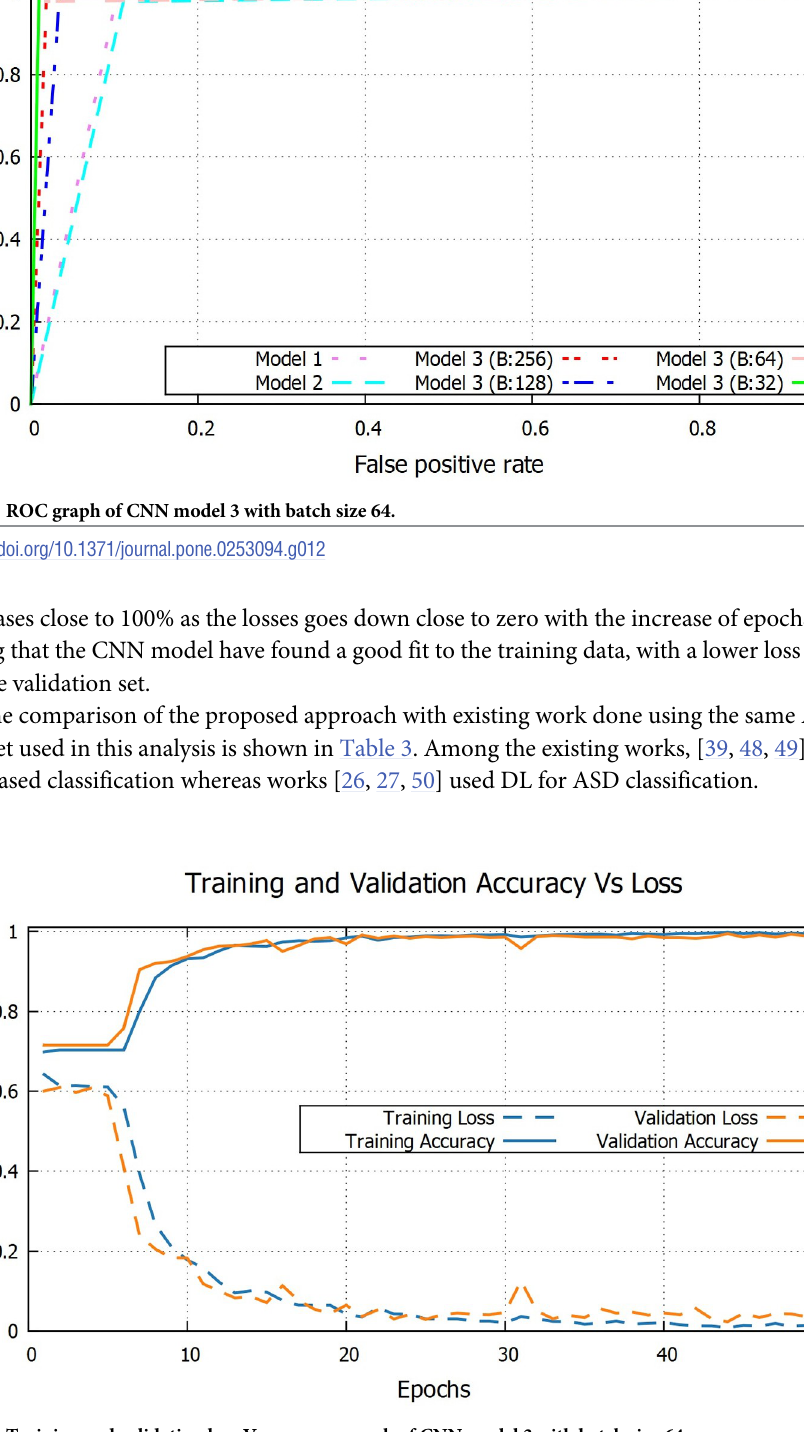
Fig 13. Training and validation loss Vs accuracy graph of CNN model 3 with batch size